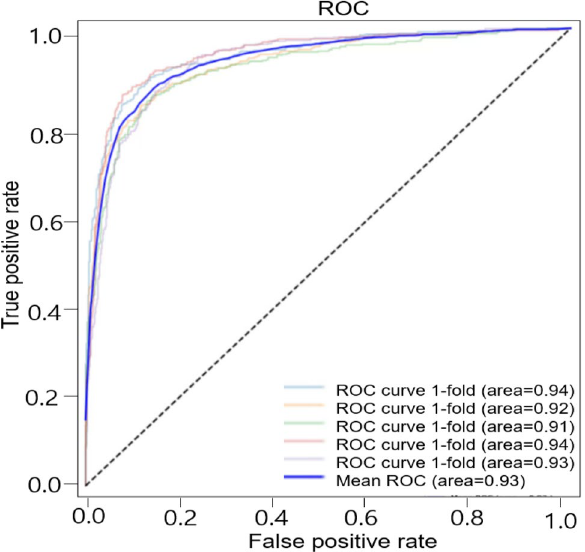
Figure 2. ROC of the model for discrimination of abnormal lung sounds. Each plot illustrates the ROC of the algorithm on the independent testing set for abnormal lung sounds, with AUC of 0.93.